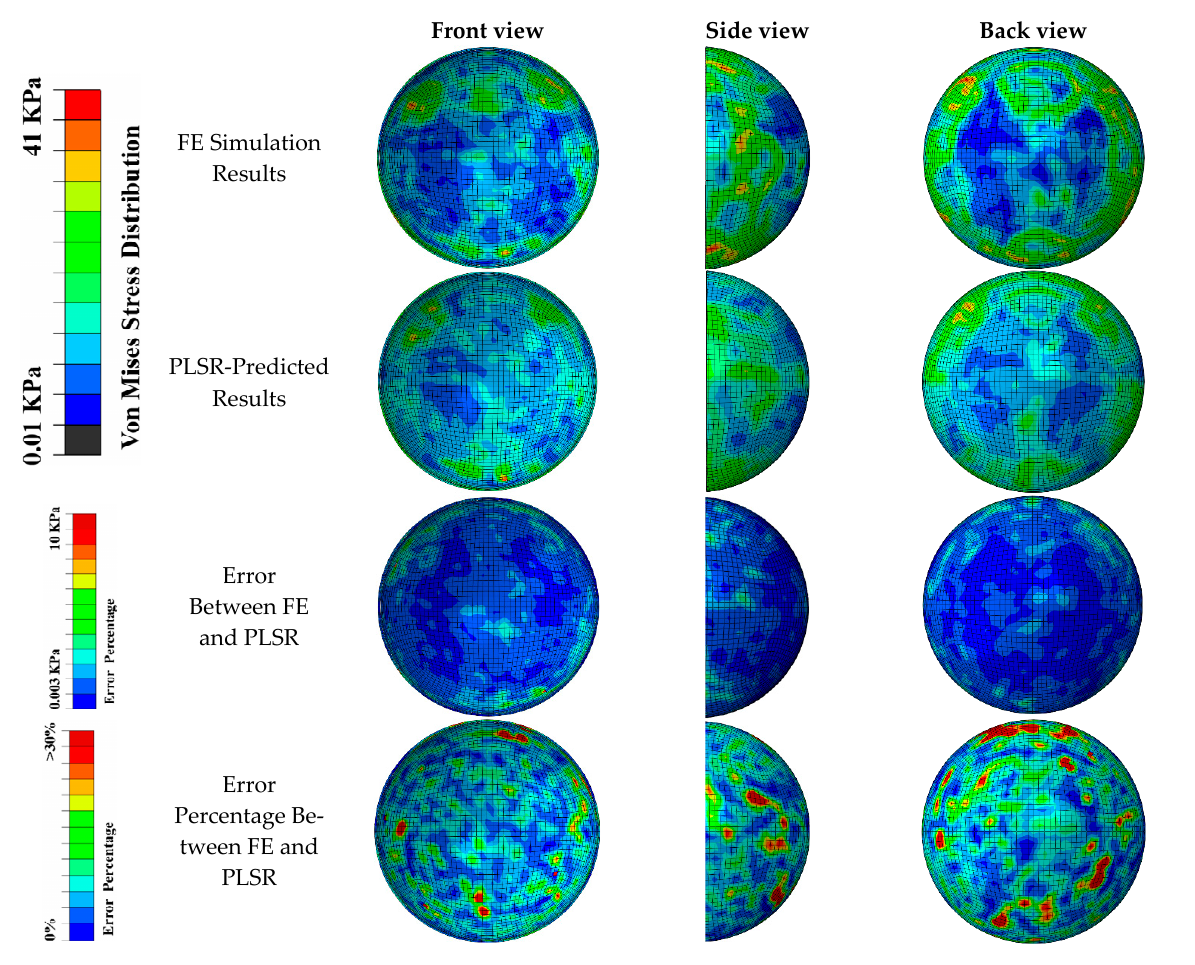
Figure 5. Comparison of FE simulated von Mises stress pattern and PLSR-predicted von Mises stress (soccer ball velocity was 35 mph with diagonal impact location). General agreements can be seen in the location and magnitude of maximum stress.